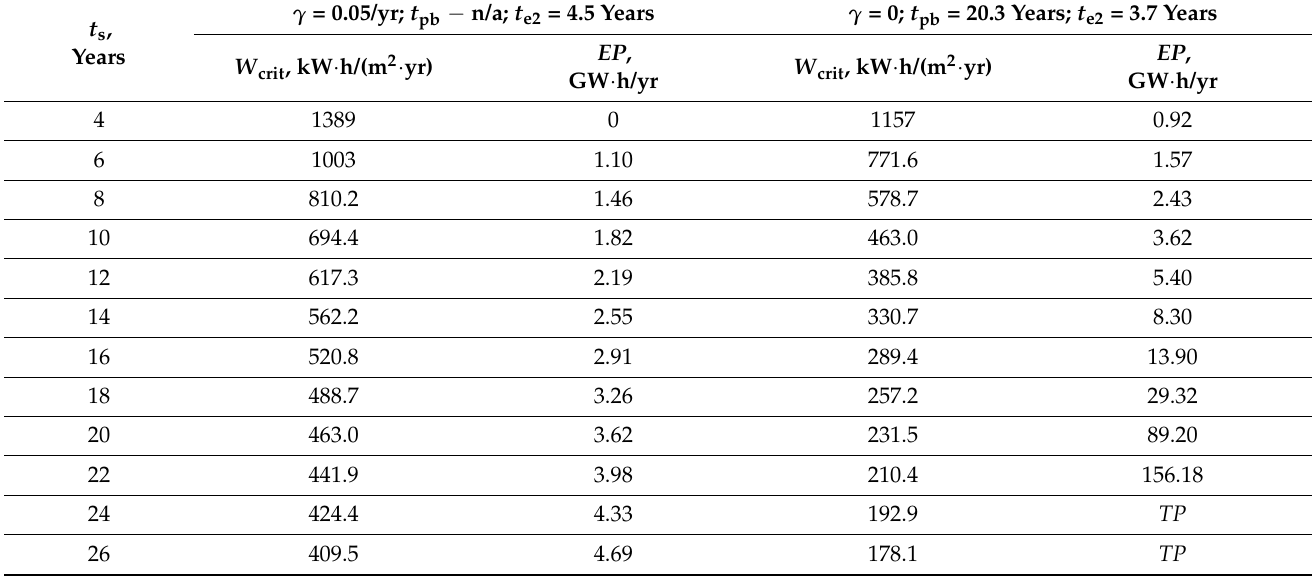
Table 12. Critical values of annual generation W crit by PV systems based on CPV modules with continuous tracking of the sun and relevant values of economic potential EP and economic surplus potential ∆ EP of solar energy for the photovoltaic energetics of the Island of Olkhon, subject to different service lifetimes of PV systems t s.